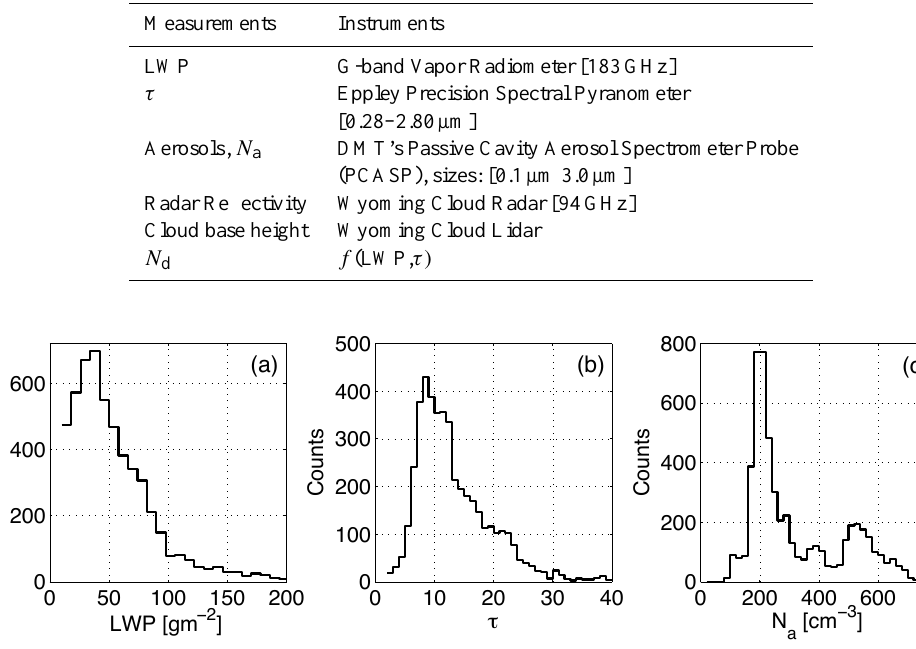
column-maximum reflectivity<-17 dBZ. 999